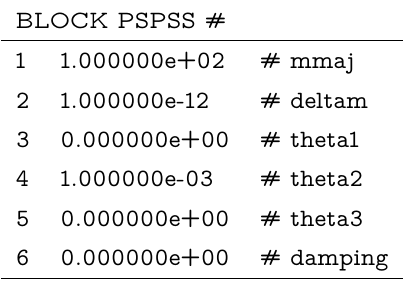
Table 2 . The parameters of the pSPSS implemented in the FeynRules model file as they appear in the MadGraph param.card